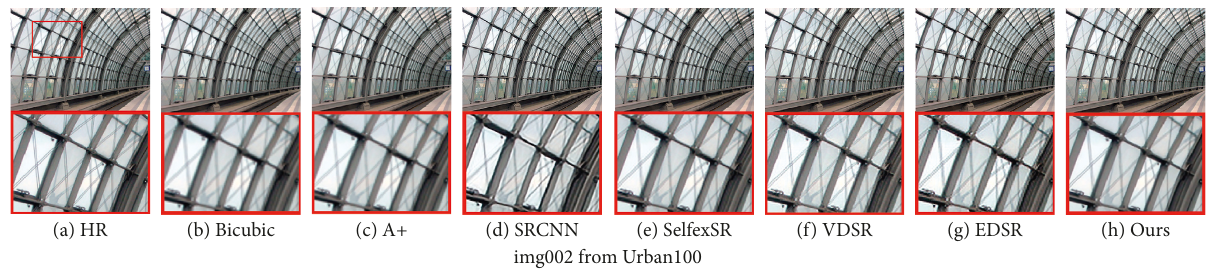
Figure 10: Super-resolution results for scale factor 2. Below each image is a partial enlargement. Table 3: Ablation study of the proposed component in reconstruction quality. Bold indicates the best performance.